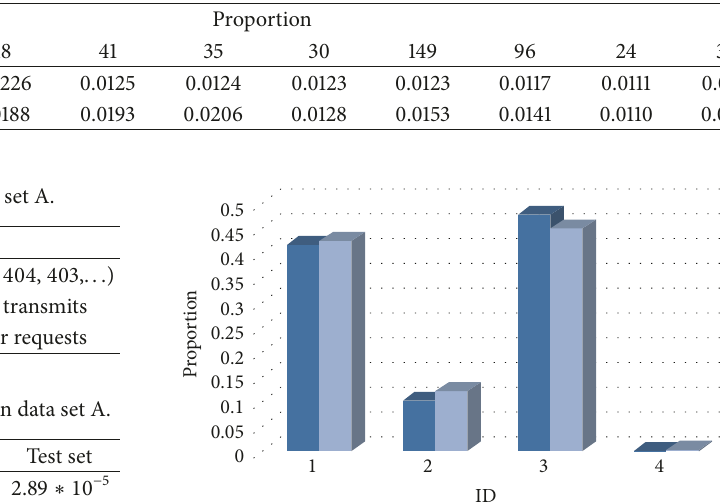
Table 1: Proportion of top 10 ID on data set A.